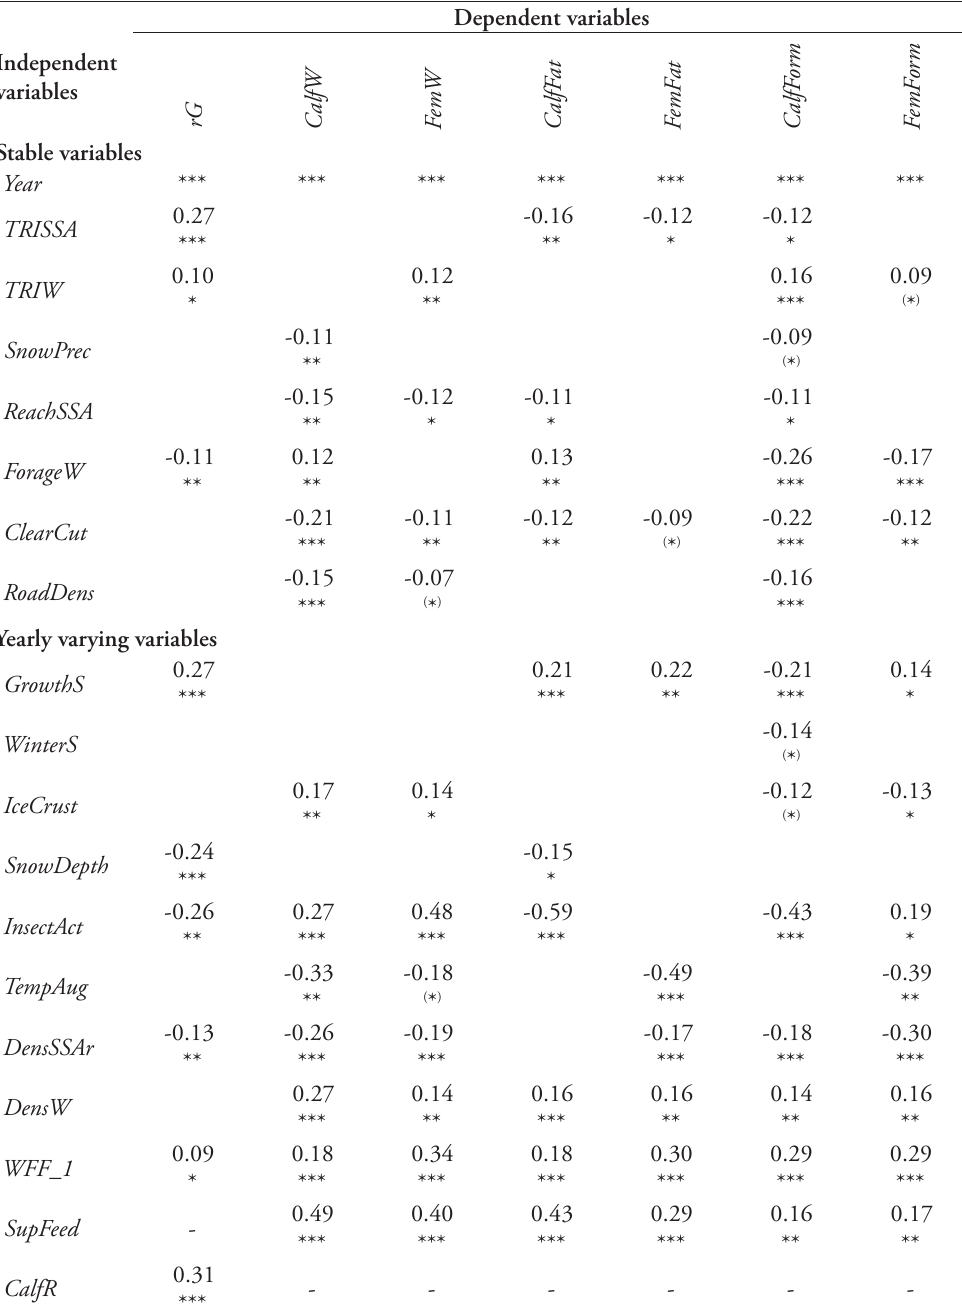
Table 2. Estimated regression coefficients of productivity variables on stable and temporally varying